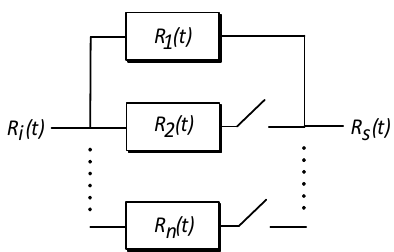
Figure 3. Reliability structure of the passive parallel redundant system (Standby).